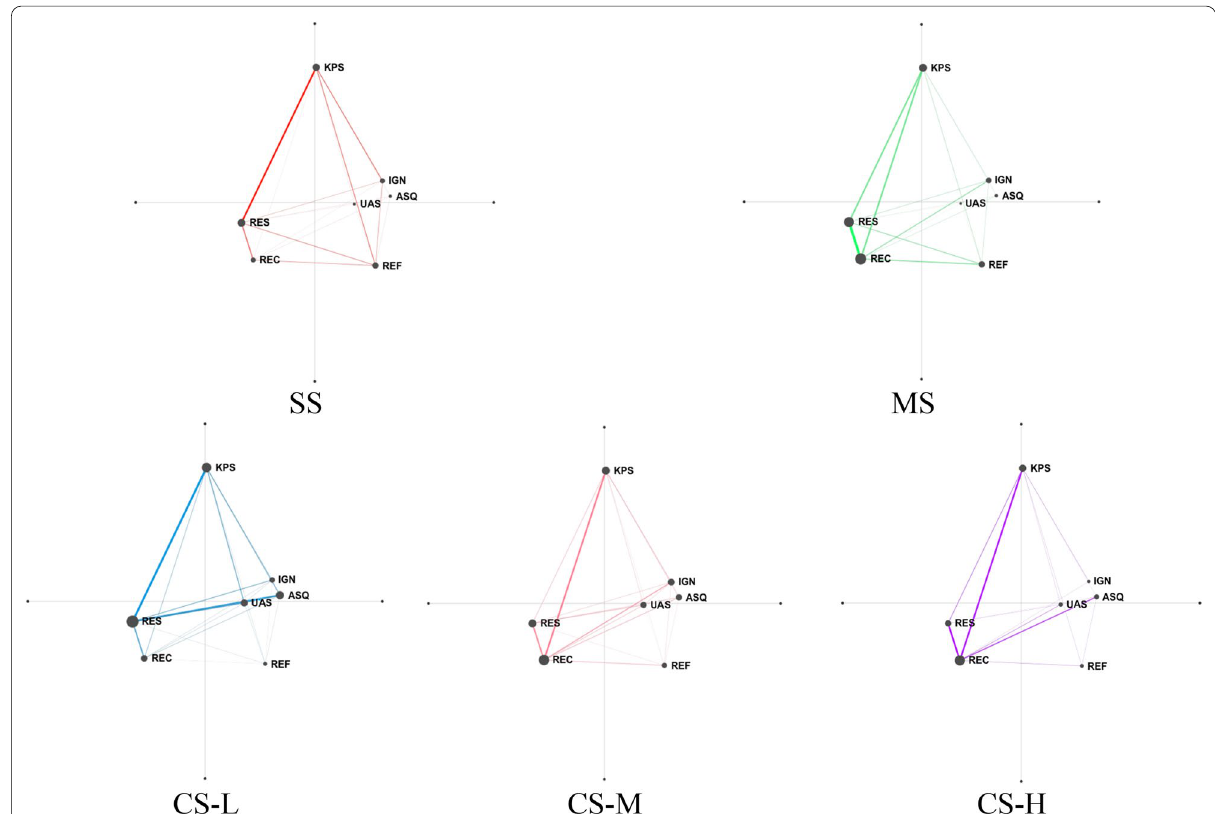
Fig. 7 The ENA plots for each instructor